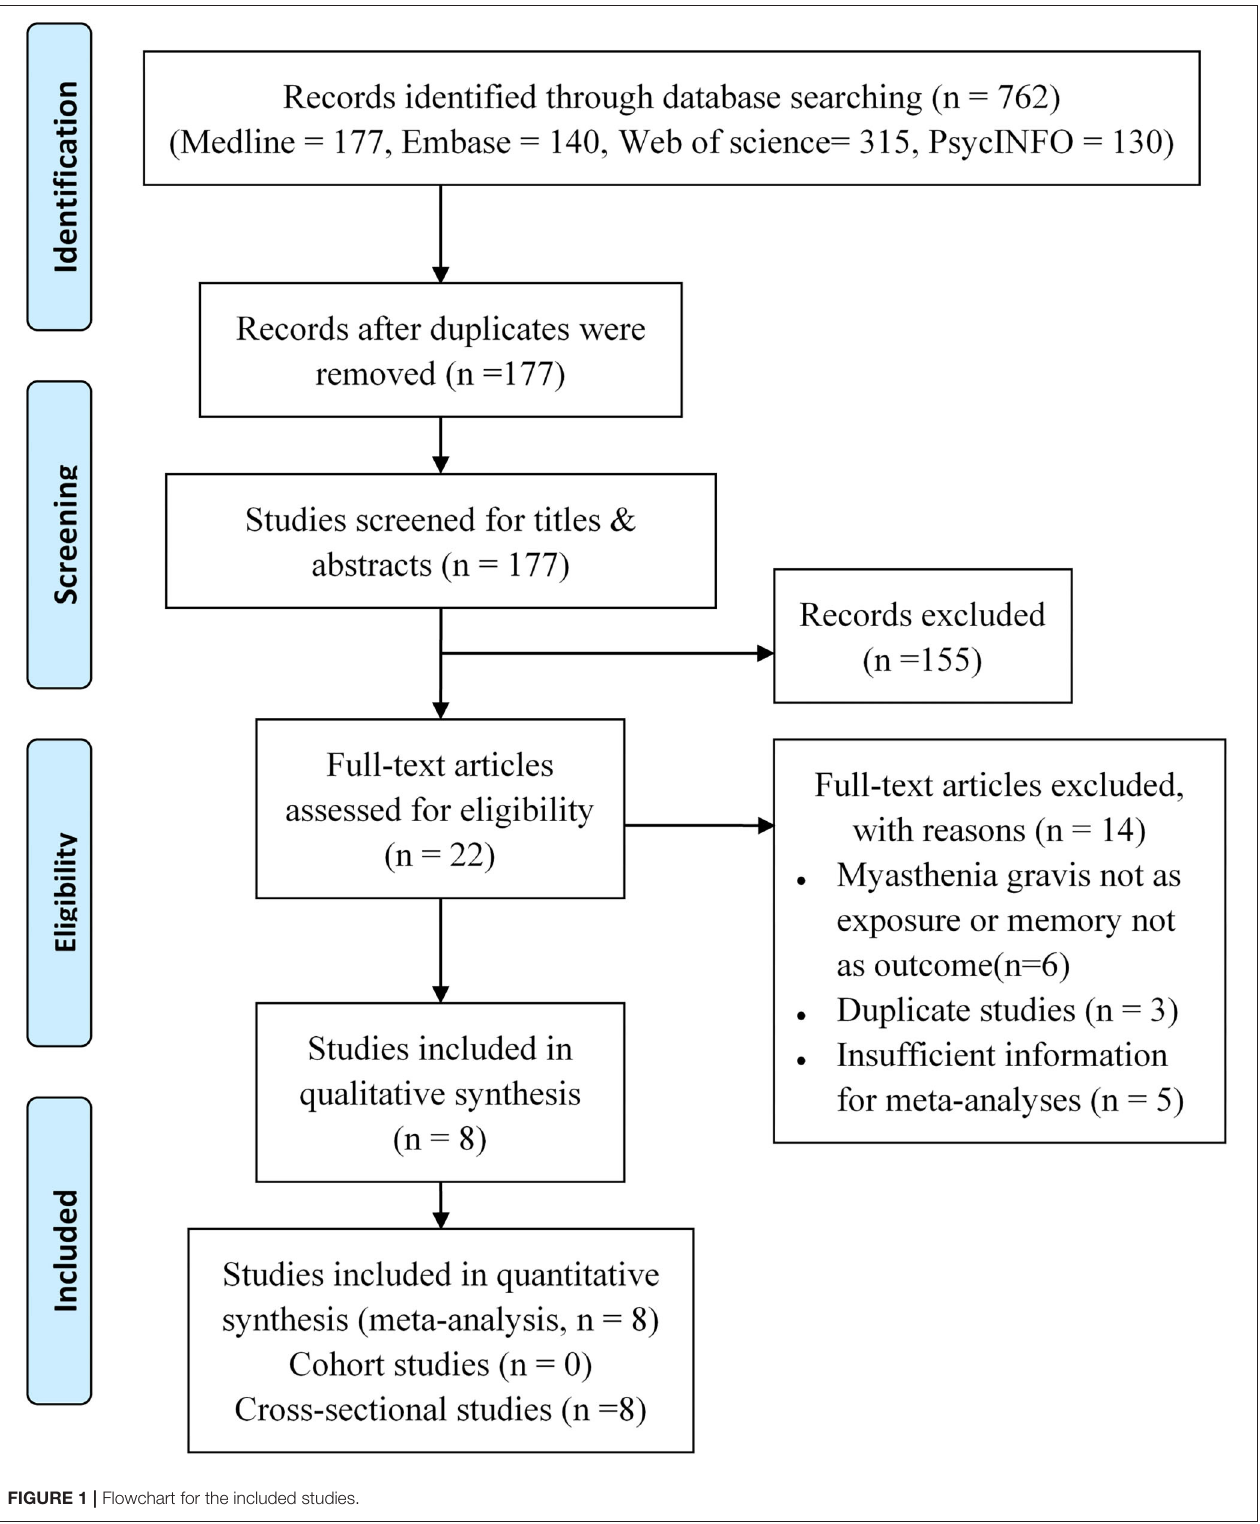
FIGURE 1 | Flowchart for the included